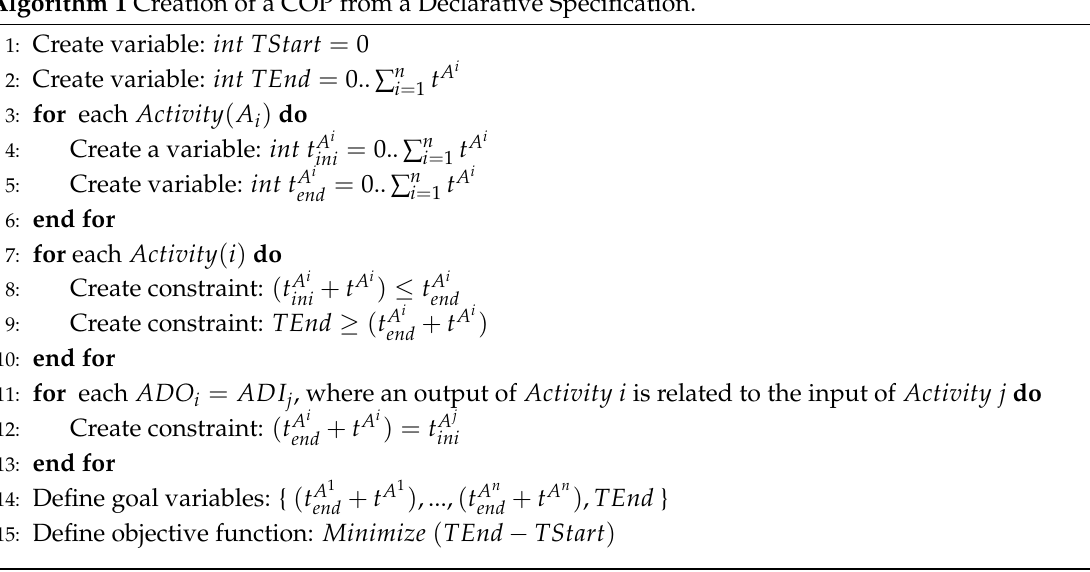
Algorithm 1 Creation of a COP from a Declarative